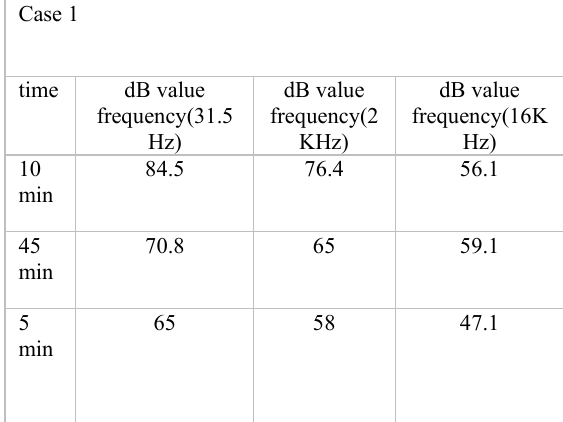
Table 2. Case 1 data for L